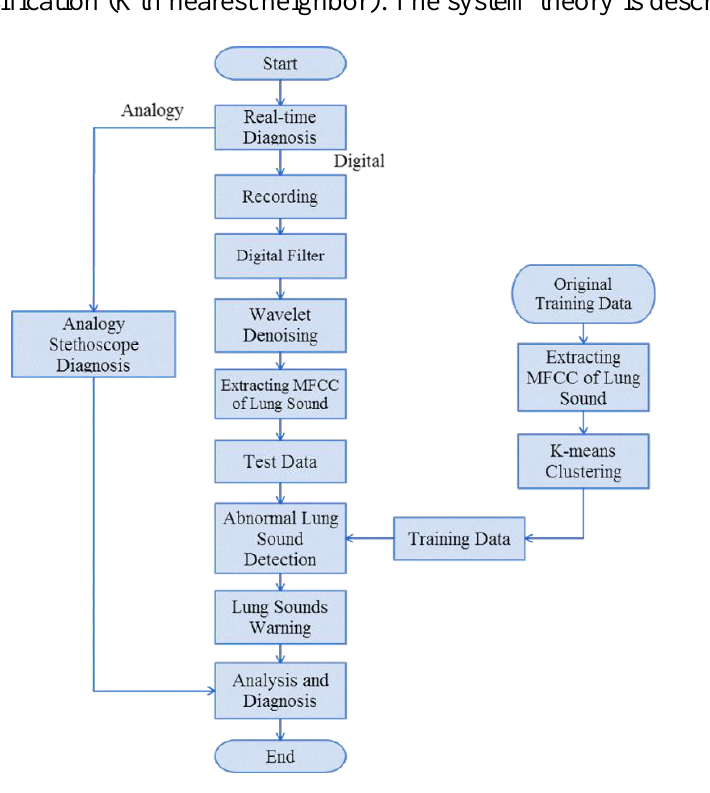
Figure 11. Process of lung sound identification